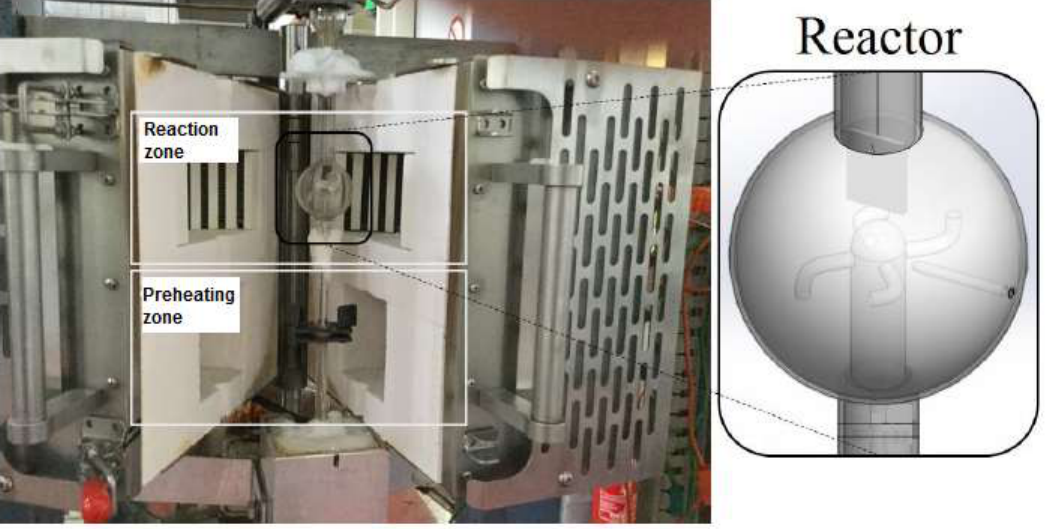
Figure 1. Illustration of the JSR reactor.